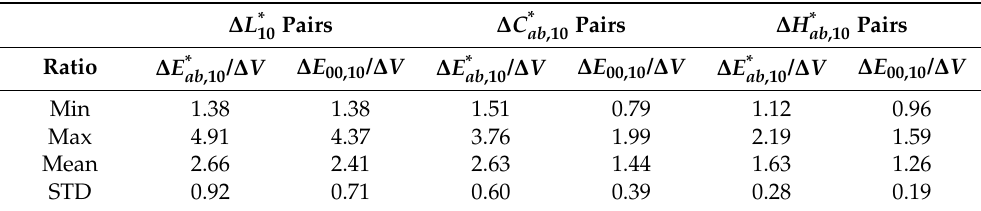
Table 2. Basic statistical results of ∆ E/ ∆ V ratios of the 42 pairs with predominant ( ≥ 85%) lightness, chroma, and hue differences (Experiment